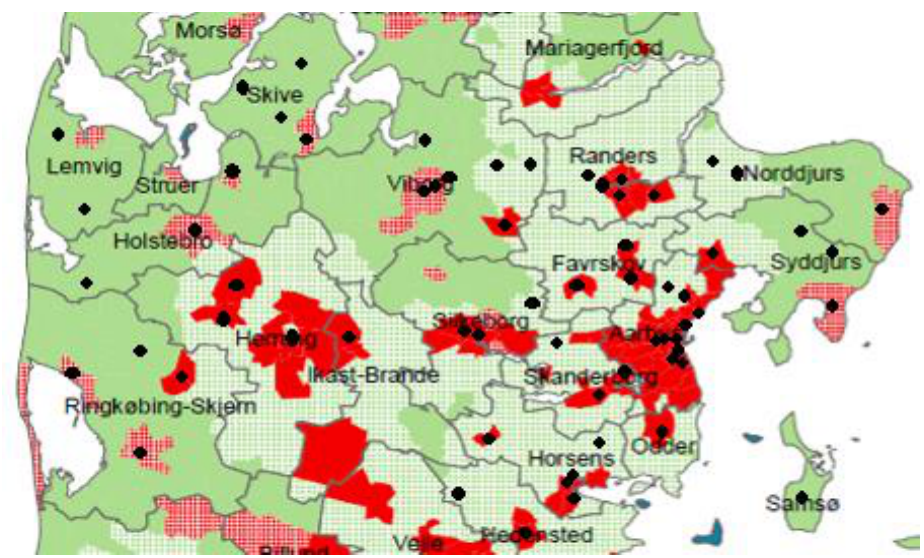
Figure 1: Distribution of chiropodist in Central Denmark Region with regard to applied urban